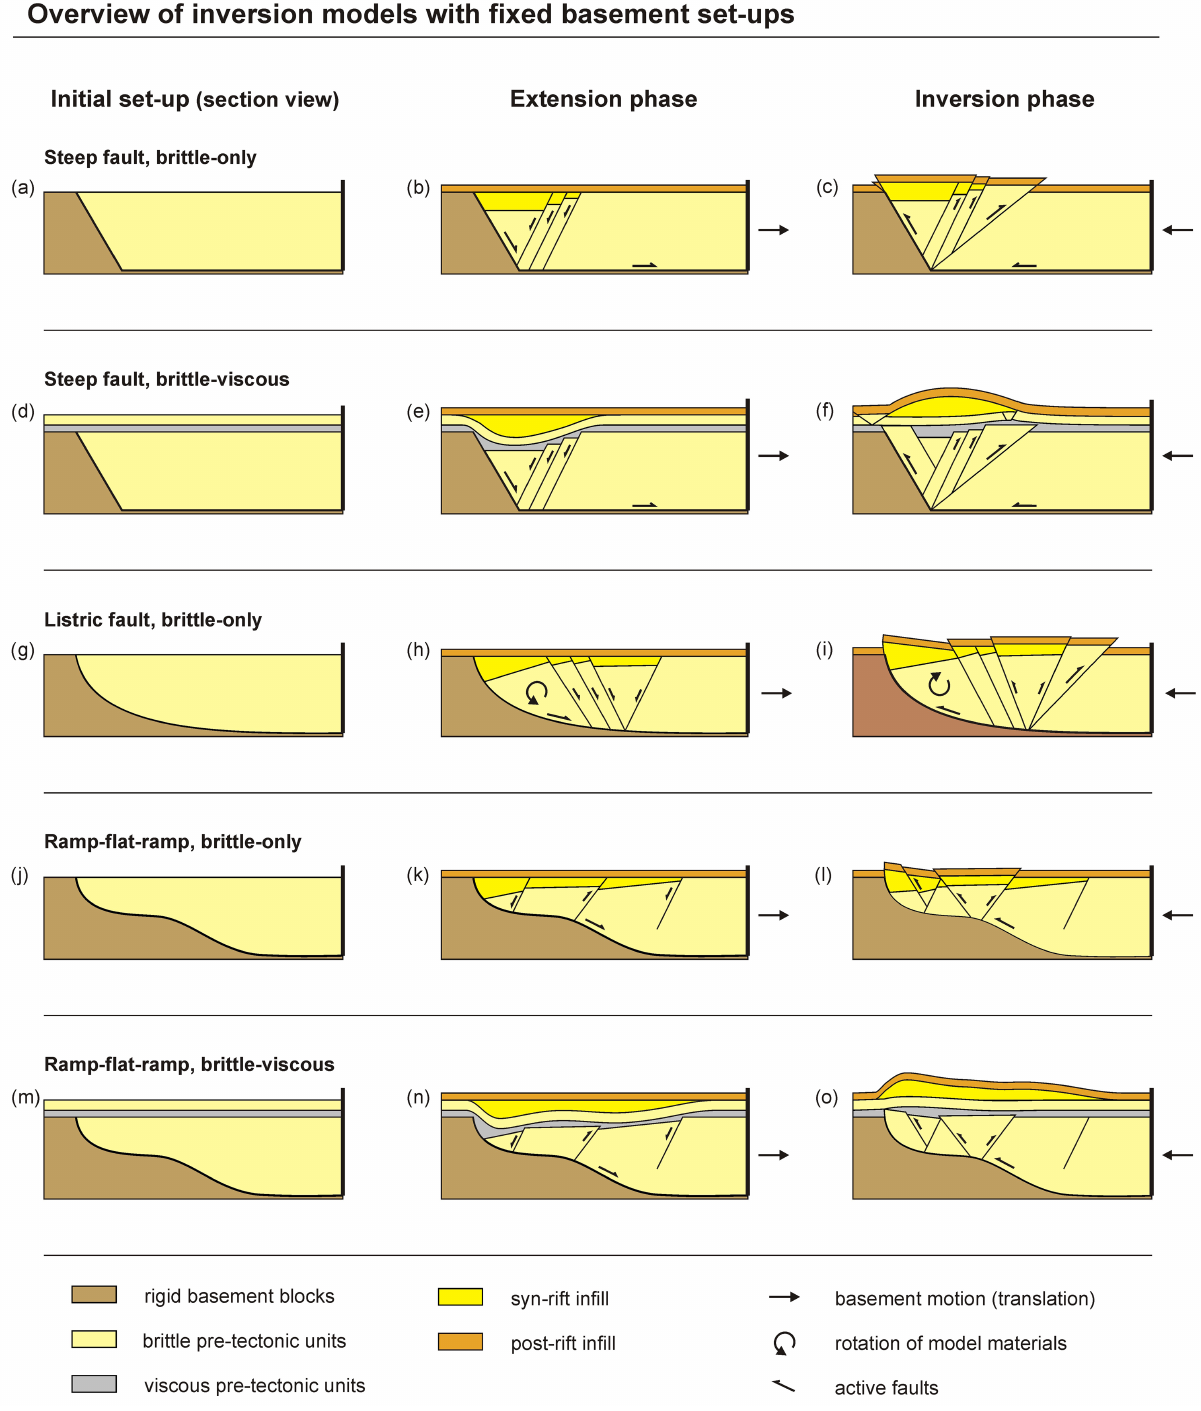
Figure 9. Section-view sketches of idealized results from basin inversion models involving a set-up with fixed basement blocks. (a–c) In- version model with steep fault set-up and brittle-only model materials. (d–f) Inversion with steep fault set-up and a brittle–viscous layering. (g–i) Inversion model with a listric fault set-up and brittle-only model materials. Modellers have also included viscous layers in such a set-up, which has a similar impact as in the steep normal fault equivalent (Ferrer et al., 2016). (j–l) Inversion model with a ramp–flat–ramp fault set-up and brittle-only model materials. (m–o) Inversion with a variable fault dip set-up and a brittle–viscous layering. Image inspired by McClay (1989, 1995), Buchanan and McClay (1991), Gomes et al. (2006, 2010), and Ferrer et al. (2016).